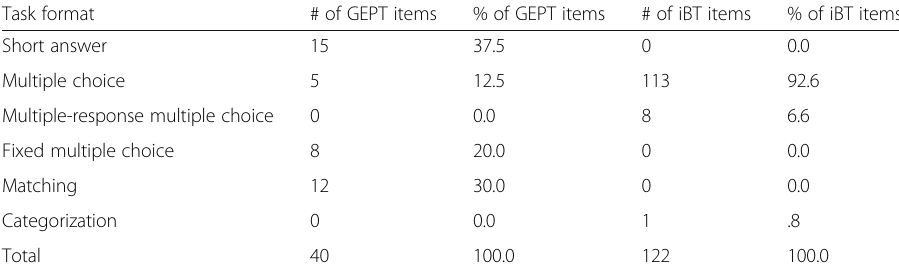
Table 5 Summary of response formats of reading items on the GEPT-A and iBT